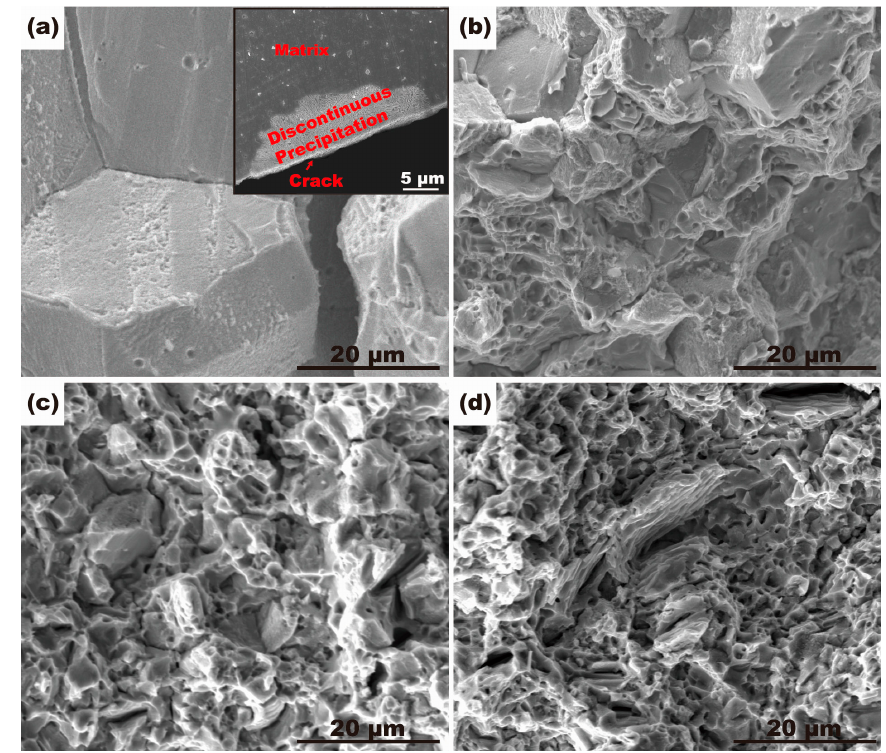
Figure 9. SEM morphologies of the fracture surfaces of the alloys with different contents of Ti: ( a ) 0% Ti, the insert image shows the tensile fracture surface after polishing; ( b ) 0.02% Ti; ( c ) 0.3% Ti; ( d ) 0.5% Ti.